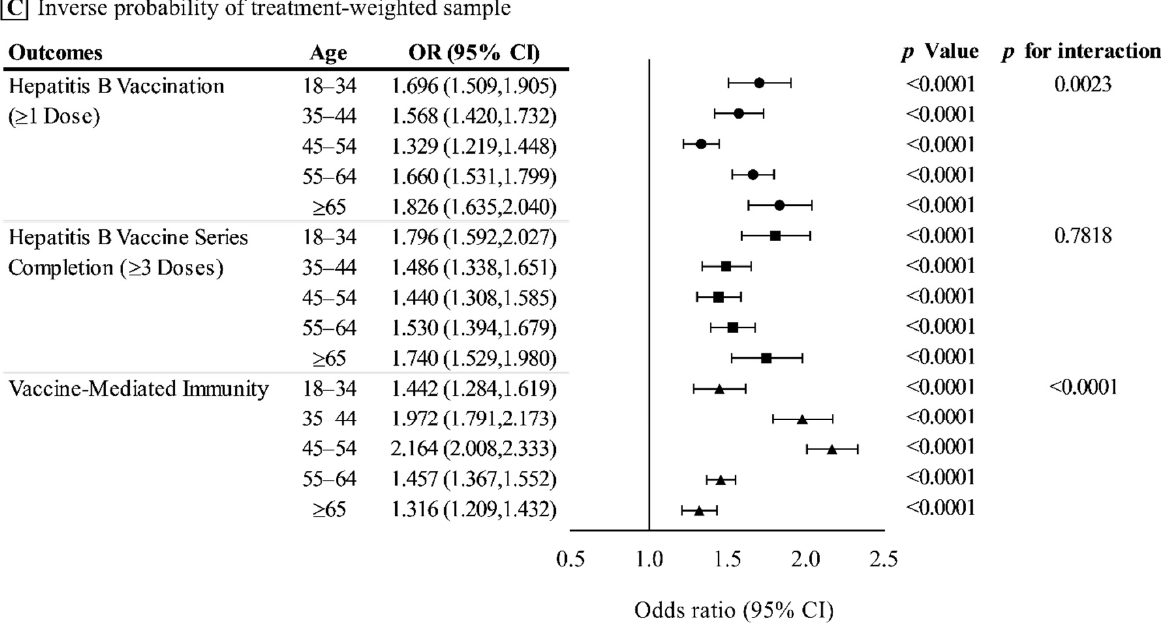
Figure 2. Association between HBVIDV program and outcomes in original sample ( A ), propensity score–matched sample ( B ) and inverse probability of treatment–weighted sample ( C ), stratified by age. a Odds ratios were adjusted for gender, educational level, employment condition, economic level, self-rated socioeconomic status, living area, multimorbidity, self-rated health condition. Table 1. Characteristic of total sample, original sample, propensity score-matched sample, and inverse probability of treatment-weighted